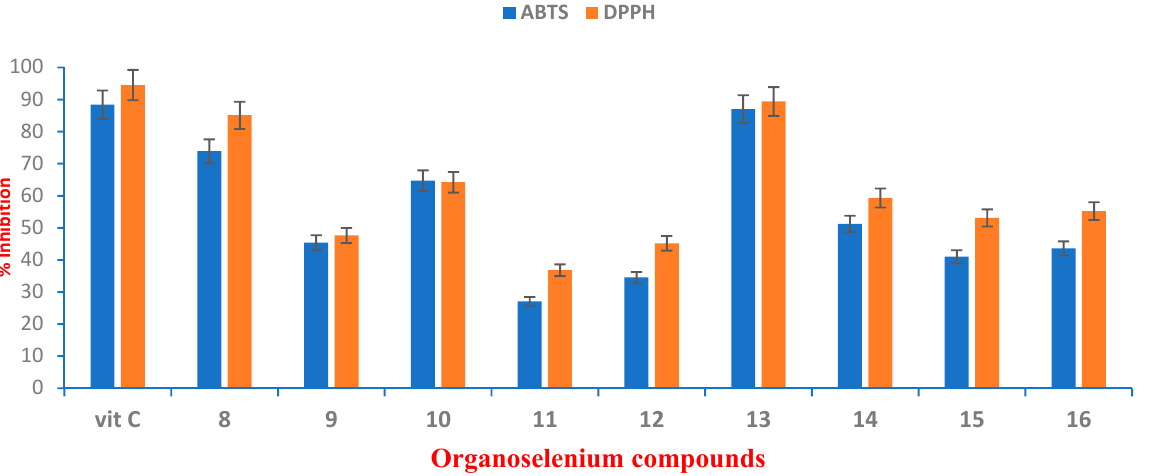
Figure 4. Estimation of the OSe compounds’ redox activities via DPPH and ABTS experiments. All tests are mean ± S.D. ABTS experiment: absorbance was followed at 734 nm for OSe compounds (50 µL, 1 mM in MeOH) and ABTS solution (60 µL). DPPH Absorbance was monitored at 517 nm for OSe compounds (200 µL, 1 mM in MeOH) and DPPH (400 µL) after 30 min.